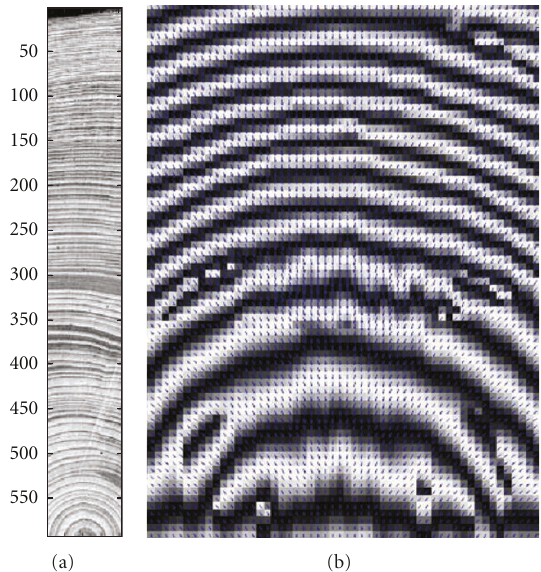
Figure 9: Instantaneous frequency density lines depicted in di ff erent portions of the FM image. (a) The original spruce image sample. (b) The FM subimage corresponding to row pixels 517–590 of the original image.